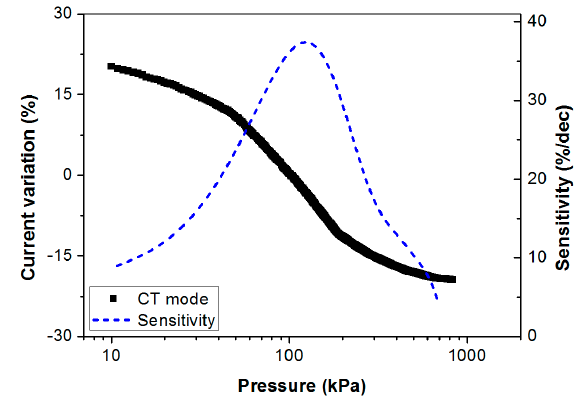
Figure 4. Output of the sensor in % versus pressure ranging from 10 to 800